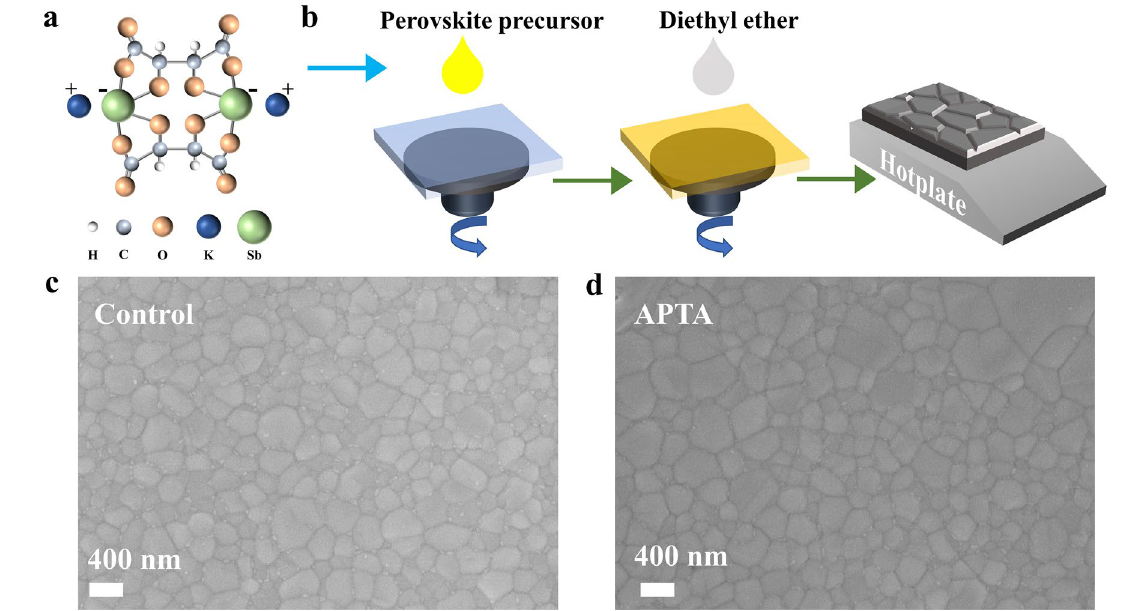
Fig. 1 a Molecular structure of APTA. b Schematic illustration of the fabrication process for the WBG perovskite films. Top-view SEM images of WBG perovskite films c without and d with APTA